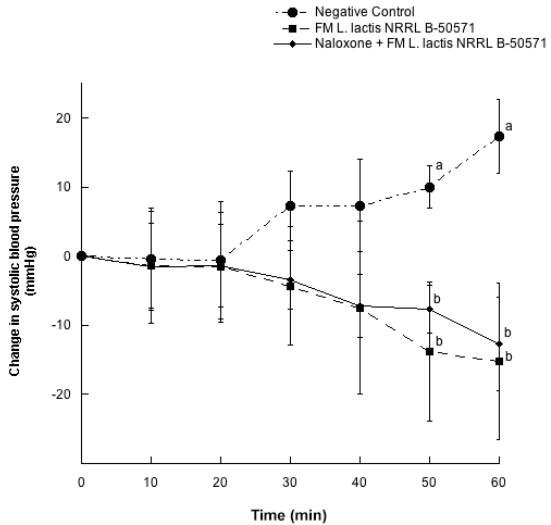
Figure 1. Change in systolic blood pressure in spontaneously hypertensive rats with different treatments. Negative control: purified water; FM L. lactis NRRL B-50571: lyophilized water-soluble extract (35 mg protein/kg body weight) of fermented milk with Lactococcus lactis NRRL B-50571; Naloxone: (1 mg/kg body weight) Antagonist μ opioid receptor + FM L. lactis NRRL B-50571: lyophilized water-soluble extract (35 mg protein/kg body weight) of fermented milk with Lactococcus lactis NRRL B-50571. Data are presented as means ± SEM. Data points sharing the same letter within a week was not significantly different ( p > 0.05).